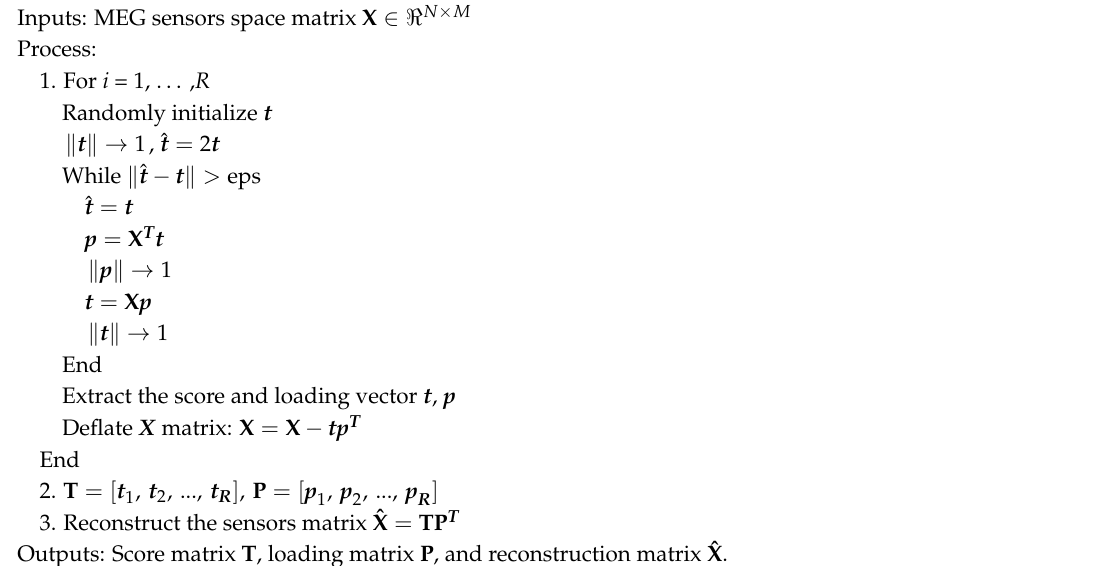
Algorithm 1. Pseudo Code for Iterative Matrix